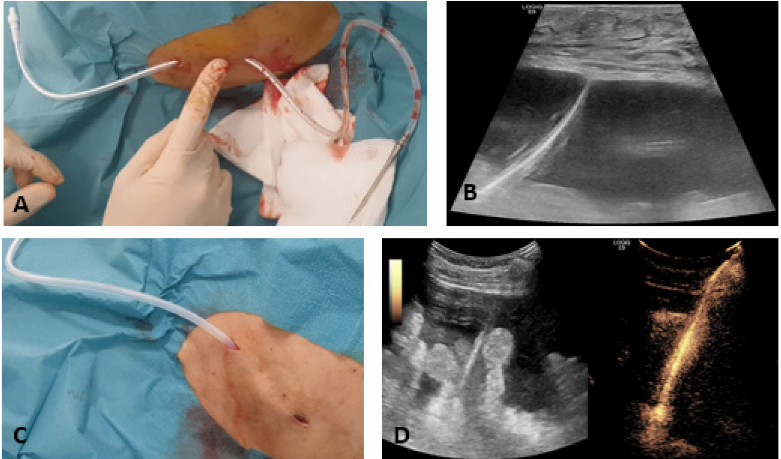
Figure 1. ( A – D ): Subcutaneous tunnelling of the PleurX catheter. The fingertip points to the position of the polyester cuff ( A ); sonographic control of guidewire position in the abdominal cavity ( B ); after using the peel-away introducer, the fenestrated part of the catheter is now inside the abdominal cavity ( C ). Optionally, the position of the catheter in the abdominal cavity can be verified by administering a few drops of SonoVue over the drainage ( D